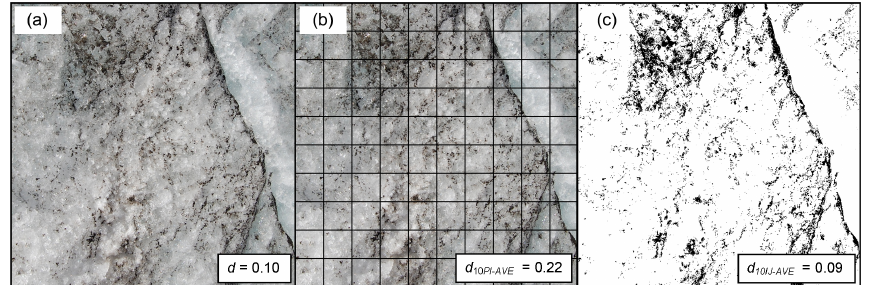
Figure 8. An example of the application of different approaches to the same image. The original image is shown in (a) . In (b) and (c) , the application of the point intercept method and our approach, respectively.